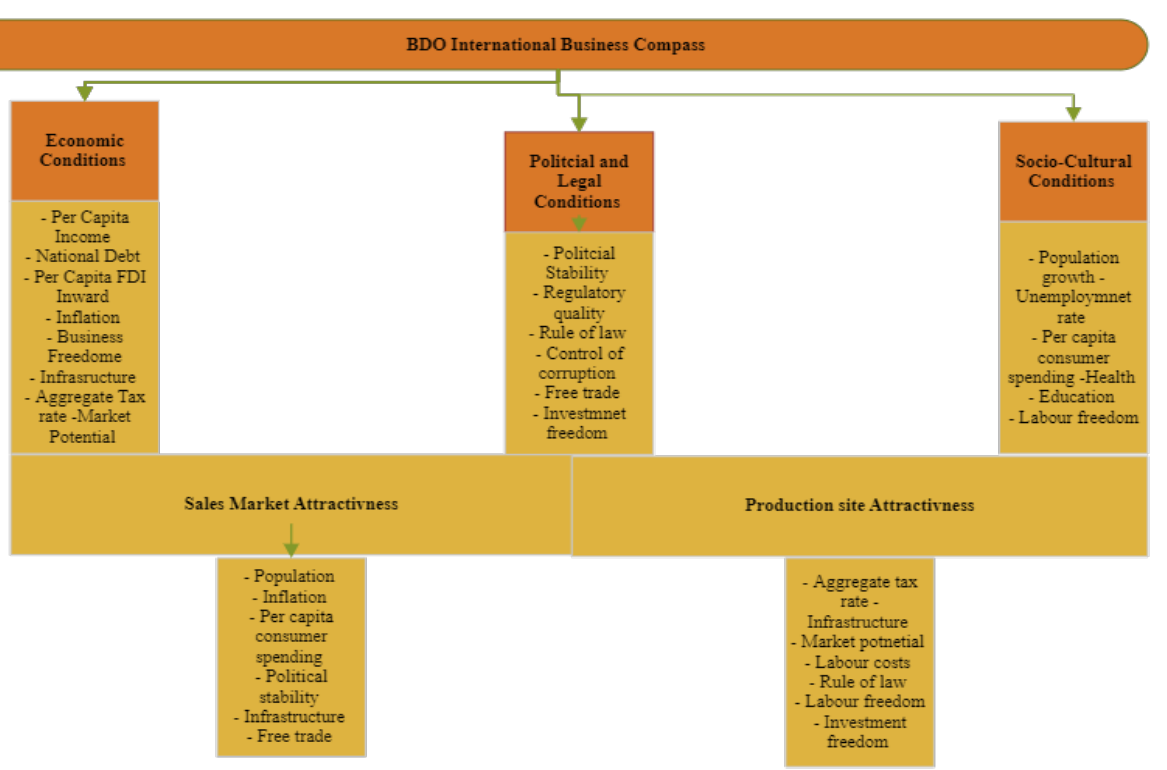
Figure 2. Business environment framework Economic and Financial